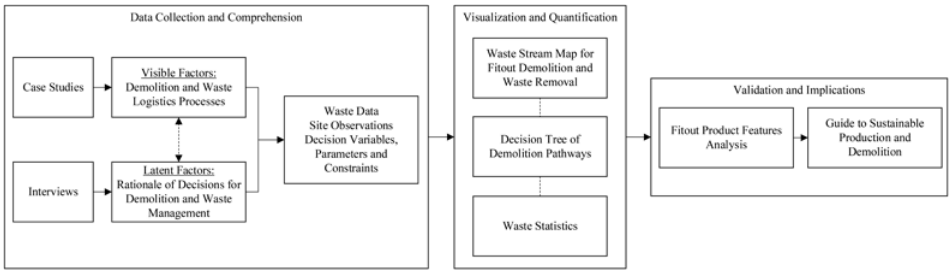
Methods and Techniques Used to Study and Validate Sustainability Barriers of Office Fit-out